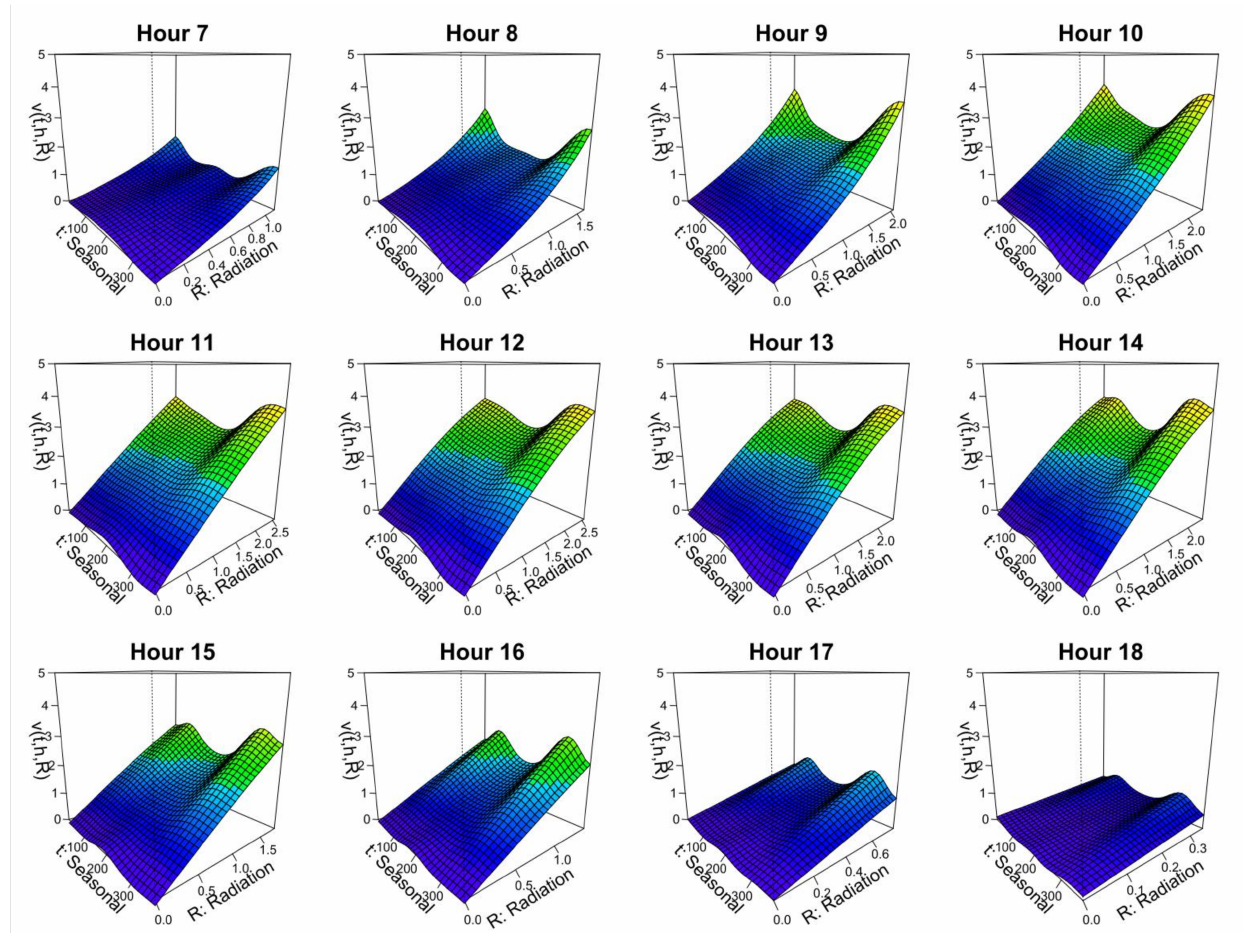
Figure 6. Trend estimation results for the M3 model (estimated from 5 years of in-sample data). Note: The units of vertical axis and “Radiation” axis are (MW) and (MJ/m 2 ), respectively. “Seasonal” denotes a yearly cyclical dummy variable (see Section